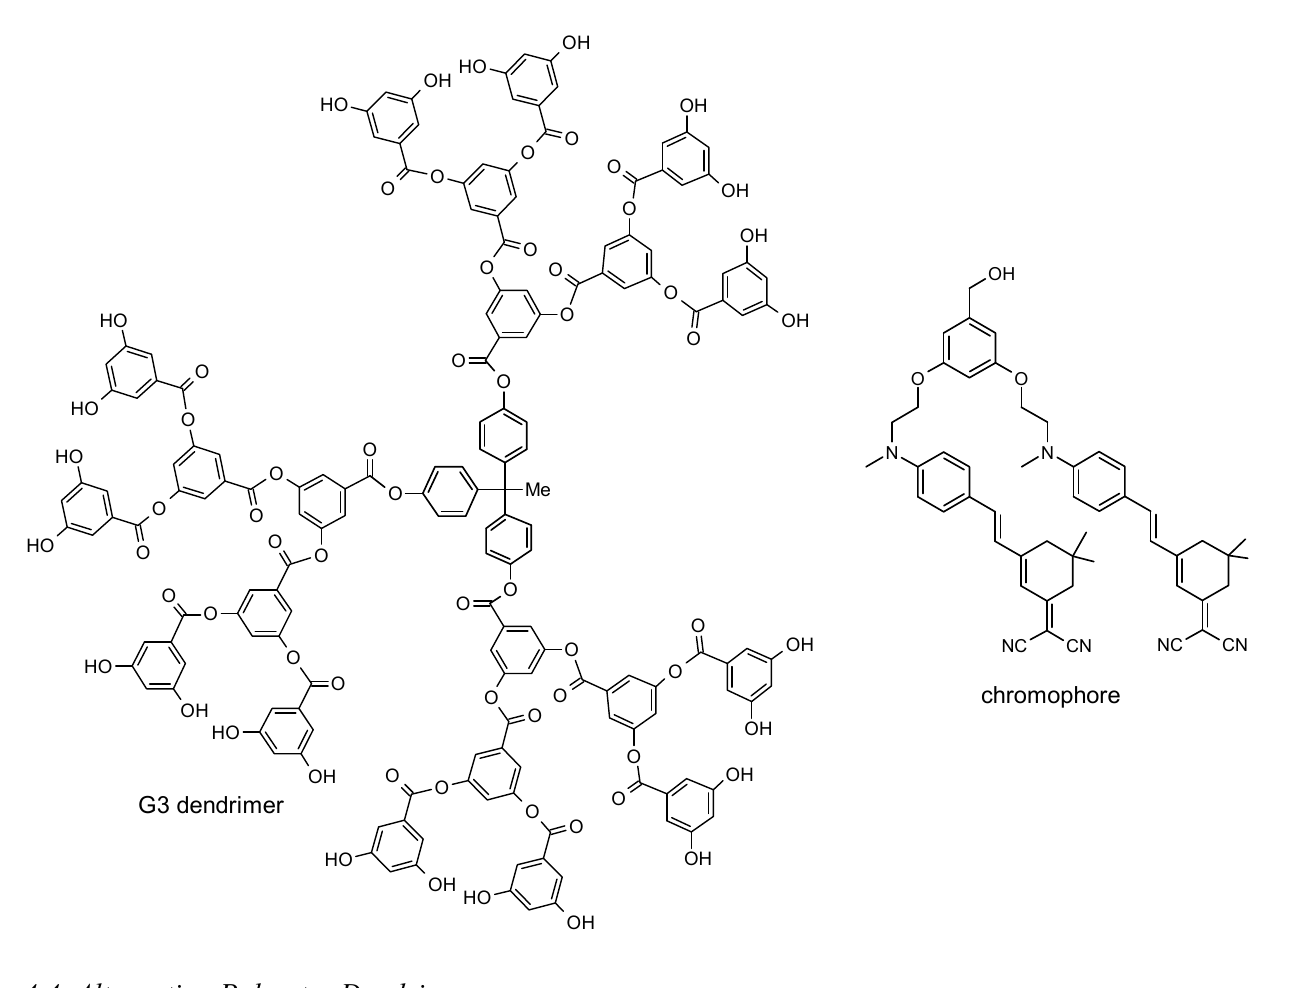
Figure 10. Optical dendrimers were prepared by using the G0 to G3 (shown on left) polyester dendrimers as nucleophiles in multiple substitutions of the benzylic hydroxyl of the chromophore on the right